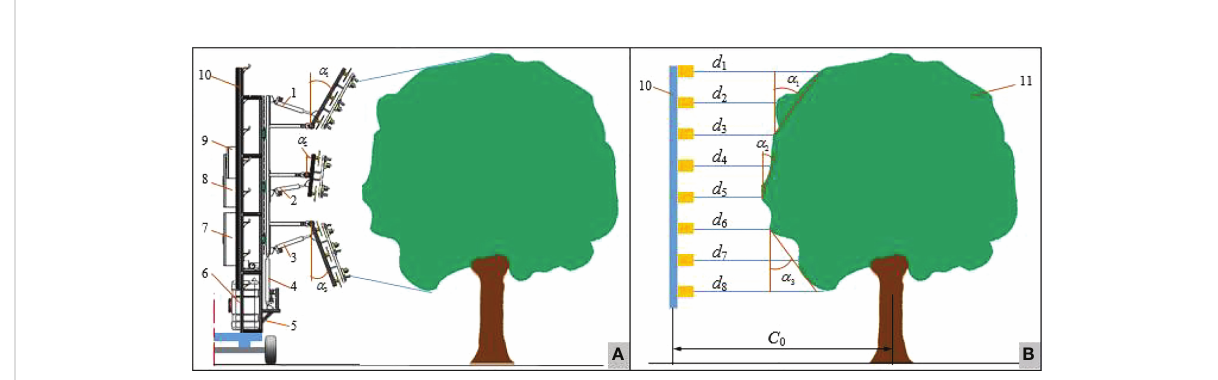
FIGURE 1 Schematic diagram of single-sided fruit tree pro fi le sprayer pro fi ling and its array ultrasonic detection canopy distance information (A) Schematic diagram of single-sided fruit tree pro fi le sprayer pro fi ling (B) Schematic diagram of array ultrasound detection of canopy distance information 1. Pro fi ling mechanism module A_up 2. Pro fi ling mechanism module B 3. Pro fi ling mechanism module A_down 4. Lifting slide module 5. Bracket module 6. Liquid supply system 7. Flow and air volume control box 8. Pro fi ling Mechanism pro fi ling control box 9. Canopy phenotyping traits detection control box 10. 8-channel array ultrasonic detection module 11.Fruit tree